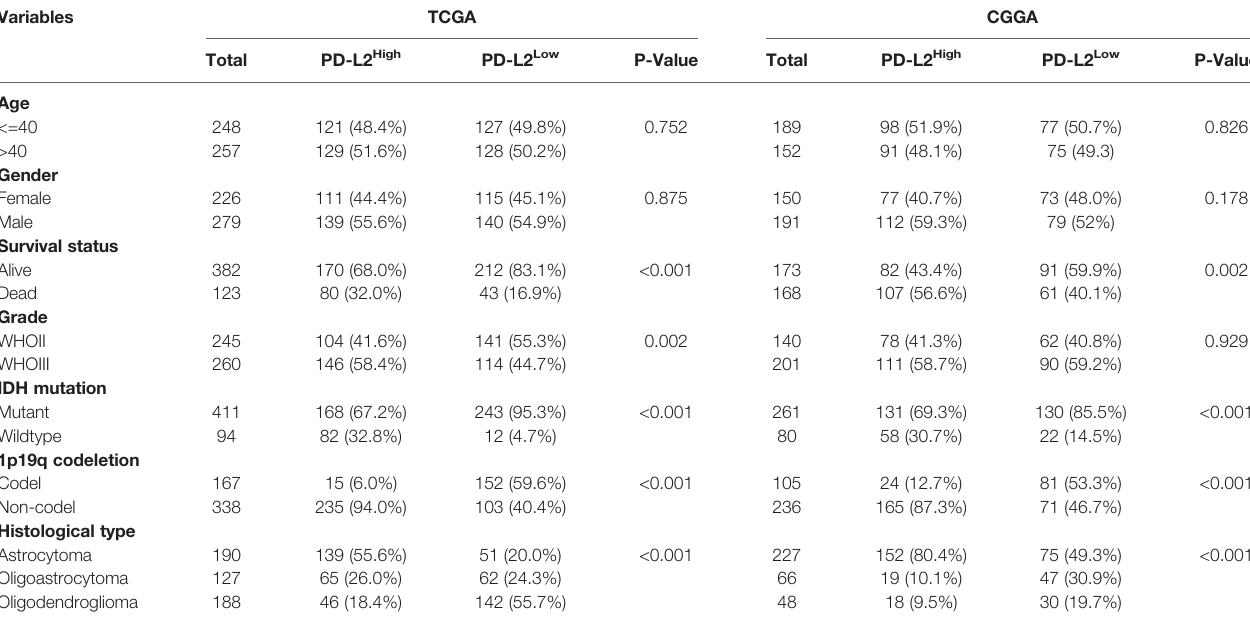
TABLE 1 | Correlation between PD-L2 expression and clinicopathologic characteristics of patients with LGGs in TCGA and CGGA